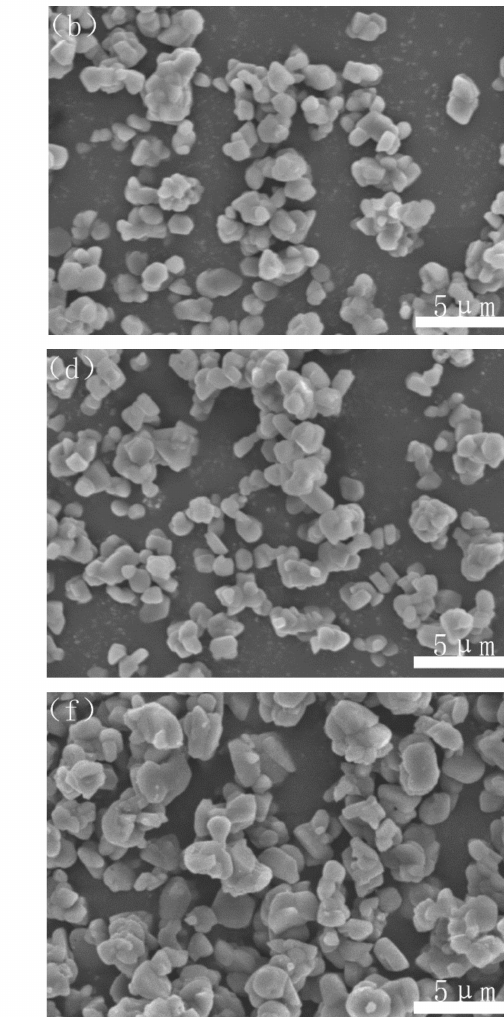
Figure 6. Morphologies of the nitridized powders with different PVB additions: ( a ) sample A; ( b ) sample B; ( c ) sample C; ( d ) sample D; ( e ) sample E; and ( f ) sample